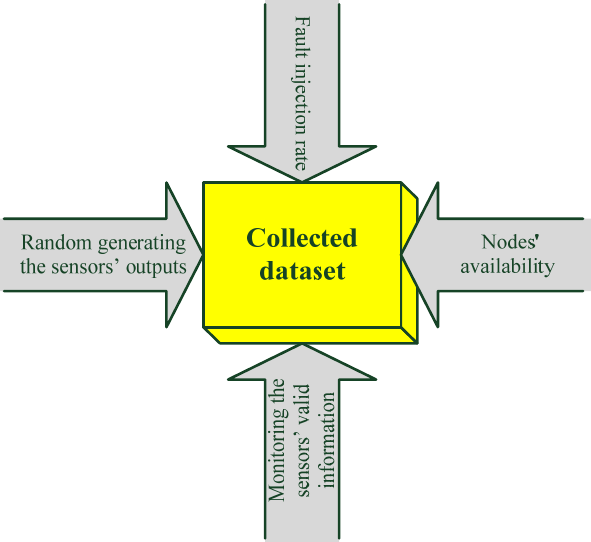
Figure 3. The collected dataset, including monitoring the sensors’ valid information, fault injection rate, random generating the sensors’ outputs, and nodes